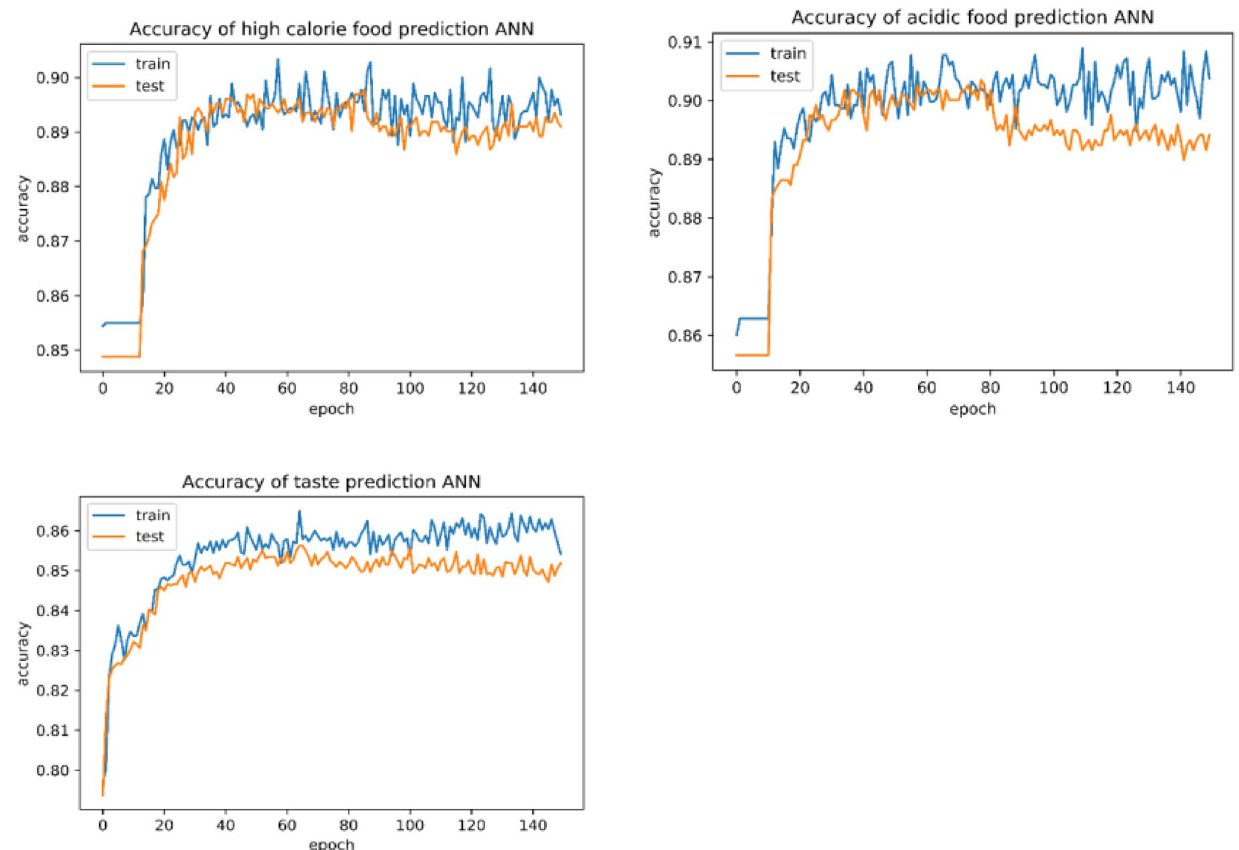
dle), Accuracy of the bi-directional LSTM-RNN learner 3 while clas- sifying recipes based on calorie content